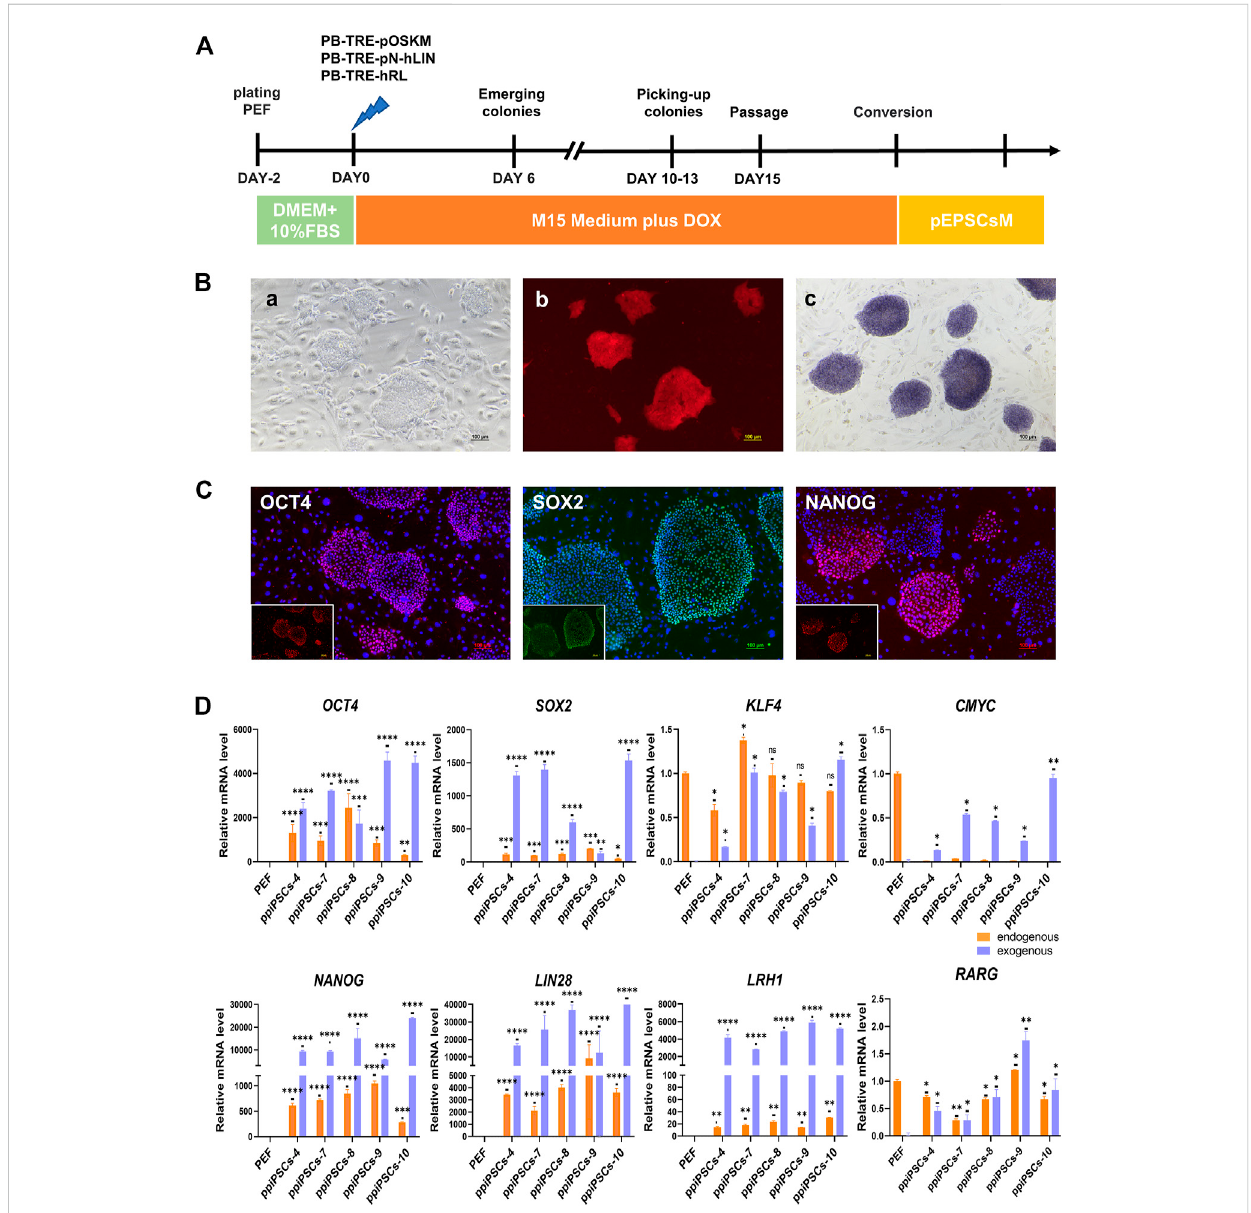
FIGURE 1 Derivation and characterization of ppiPSCs cells. (A) Schematic diagram of the establishment of ppiPSCs. (B) The morphology of ppiPSCs. (a) The morphology of ppiPSCs-4 colony at passages 21. Scale bars, 100 μ m; (b) . PpiPSCs-4 cell line was OCT4-tdTomato + ; (c) . AP staining of ppiPSCs cells. (C) The immuno fl uorescence staining of pluripotency markers OCT4, SOX2 and NANOG in ppiPSCs colonies cultured on STO cells. Scale bars, 100 mm. (D) qPCRanalysisofendogenous andexogenous transcriptionfactors of OCT4 , SOX 2, KLF 4, CMYC , NANOG , LIN28 , LRH1 and RARG inppiPSCs lines4, 7, 8, 9 and 10. Data are depicted as mean ± SD. * p < 0.05, ** p < 0.01, *** p < 0.001, **** p < 0.0001, ns, no statistical signi fi